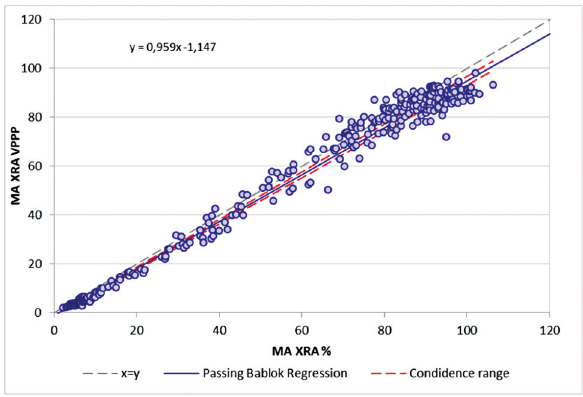
Fig. 5 Comparison betweenTXRA PPP ( ¼ traditional LTA) against the VPPP method (without autologous PPP). Individual results from 47 patients tested with seven different reagents (329 individual data points) are shown with either PPP or VPPP as the reference. Pearson ’ s correlation coef fi cient ( R 2 ) is